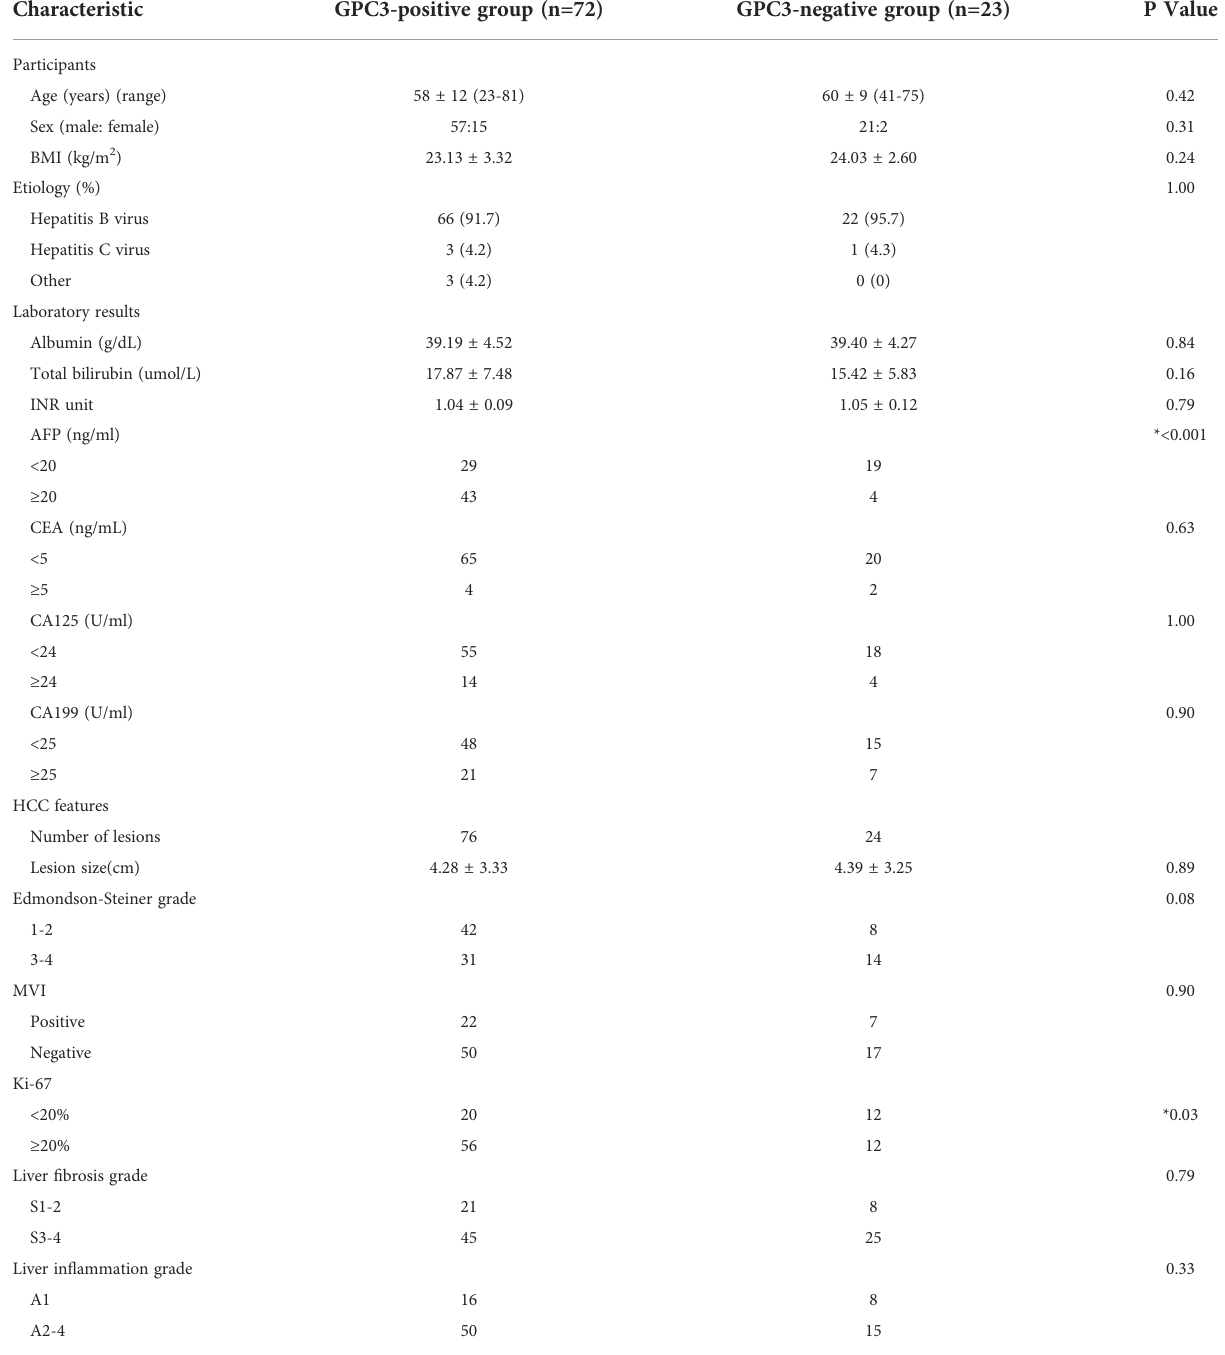
TABLE 1 Comparison of clinicopathologic characteristics of participants with GPC3-positive and GPC3-negative HCC.